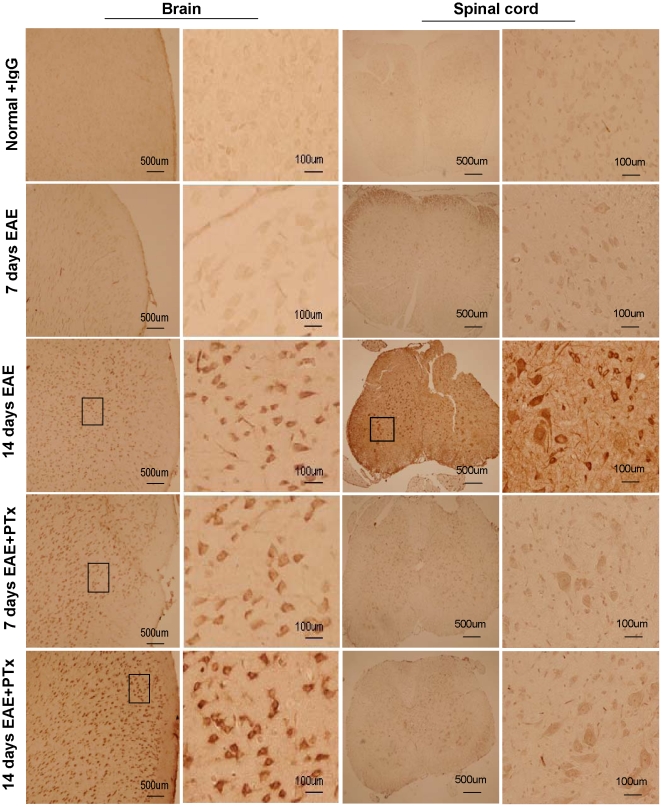
Rabbit immunoglobulin G (IgG) penetration into the frontal lobe parenchyma and thoracolumbar spinal cord in control, EAE, and EAE +PTx icv (n = 7/group).Normal +IgG: age-controlled normal mice without EAE receiving a single i.p. injection of rabbit IgG (100 µg/mouse). 7 days EAE: EAE mice on day 7 post immunization; no penetration of rabbit IgG observed in the brain or spinal cord. 14 days EAE: EAE mice on day 14; marked penetration of rabbit IgG noted in both brain and spinal cord. 7 days EAE +PTx: EAE +PTx icv mice on day 7 post immunization; marked penetration of the brain, but no penetration of the spinal cord. 14 days EAE +PTx: EAE +PTx icv mice on day 14 post immunization, continued evidence of brain penetration, no penetration of the spinal cord. Note the dramatic opening of the BBB on Days 7 in EAE +PTx icv group relative to EAE on day 7.